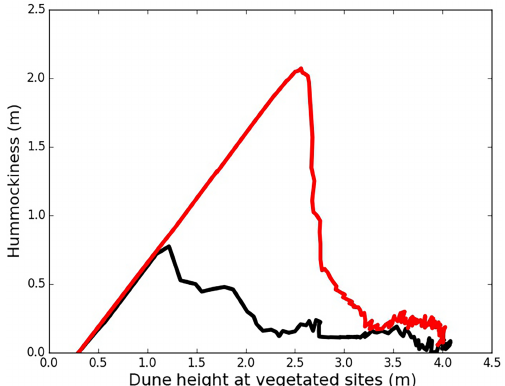
Figure 3. Phase plot of two numerical model experiments – the ex- periment in black has a larger growth parameter ( β ) and therefore faster lateral growth and lower hummockiness than the red exper- iment. All model iterations begin at (0.3, 0), reflecting the initial height of the planar sloping surface (0.3m) at the location of the dune vegetation plantings. As the model iterates, the hummocky dunes develop, as vegetated sites grow in height more than unvege- tated sites (which must wait for vegetation to grow before increasing in height). After vegetation propagates to these sites, a continuous foredune ridge develops and hummockiness reduces to zero. The maximum hummockiness and the trajectory through phase space is set by gap size ( w ), the vertical vegetation growth parameter ( H veg ) and the lateral vegetation growth parameter ( β